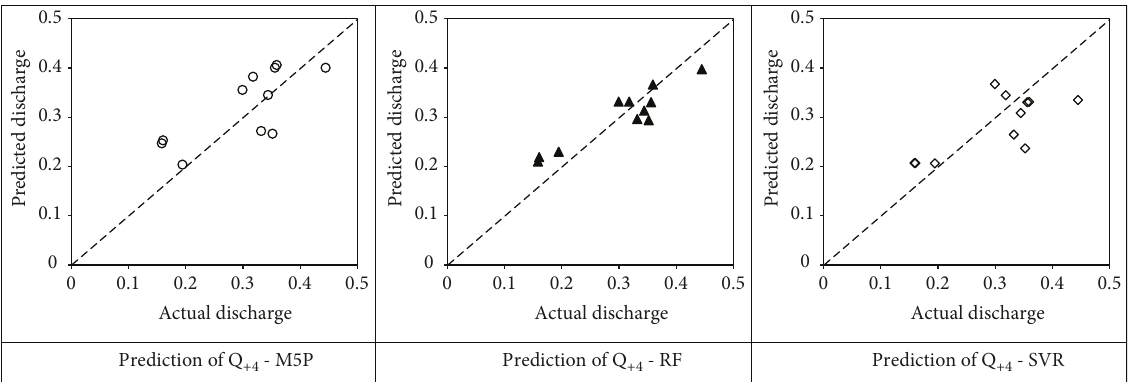
Figure 17: Comparison between predicted and observed discharges (m 3 /s), 4-month input.